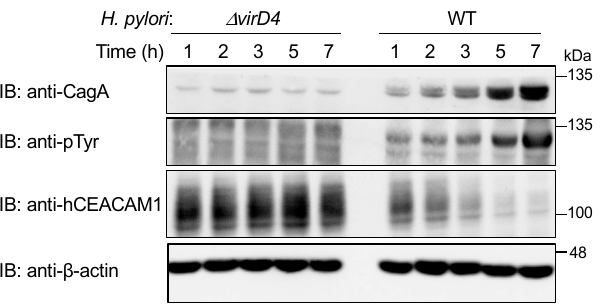
Figure 5. H. pylori T4SS contributes to deduction of the level of cellular CEACAM protein. AGS cells were infected with wild-type (WT) H. pylori or isogenic Δ virD4 strain for consecutively 7 h at a MOI of 100. The cells were harvested and analyzed for CagA, tyrosine phosphorylation (pTyr) of CagA, and human CEACAM1 (hCEACAM1) proteins. Experiments were carried out in biological duplicates ( n = 2) and the representative images are shown.